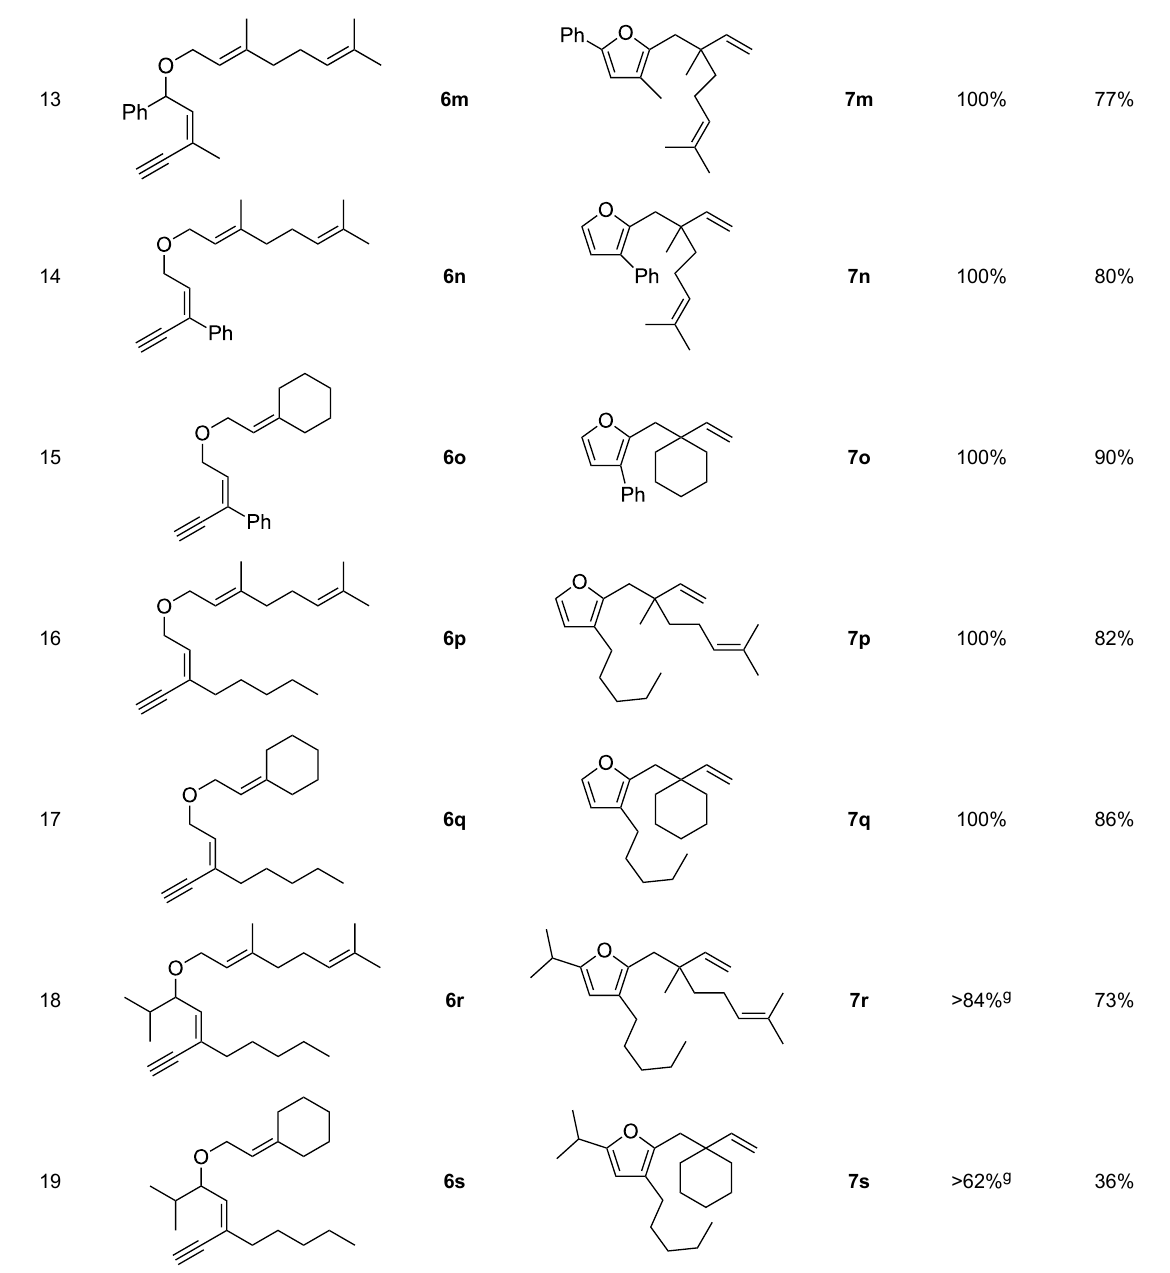
Table 1: Scope of the gold(I)-catalyzed formation of furans. a